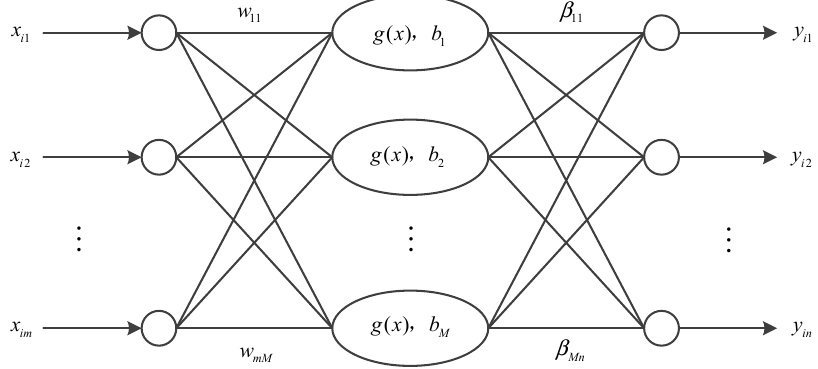
Figure 3. E xtreme learning machine (ELM) network model. Figure 3. Extreme learning machine (ELM) network